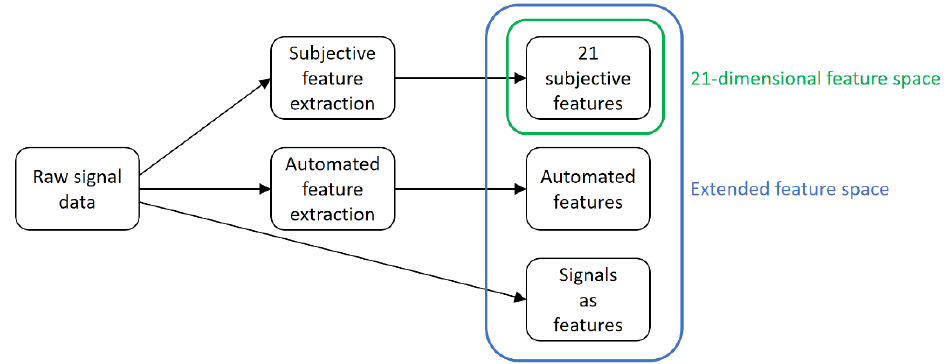
Figure 3. Feature engineering block diagram.